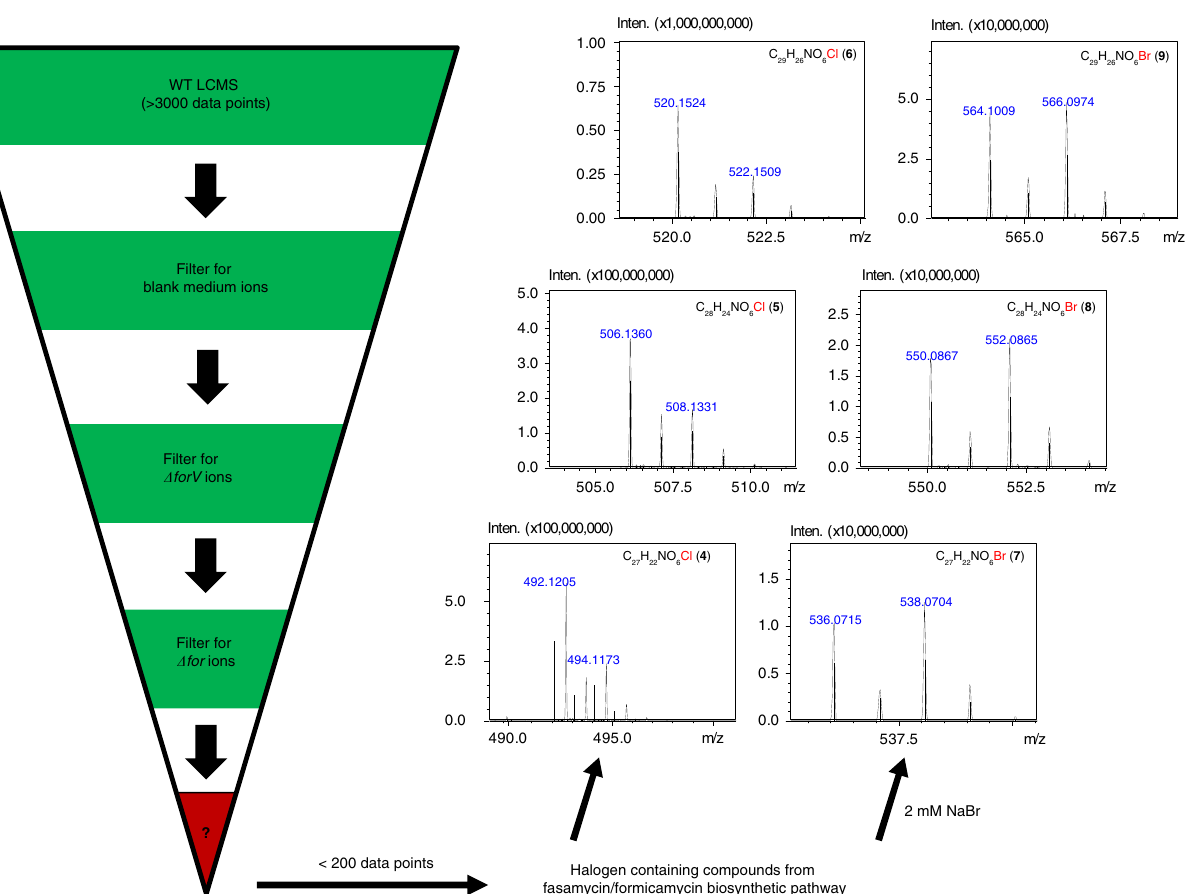
Fig. 2 Metabolomics pipeline. Dereplication, based on for biosynthetic mutants and exogenous bromide addition, led to the identi fi cation of the new congeners 4 – 9 with characteristic halogen-containing patterns (strain Δ forV lacks a halogenase gene; Δ for lacks the entire biosynthetic gene